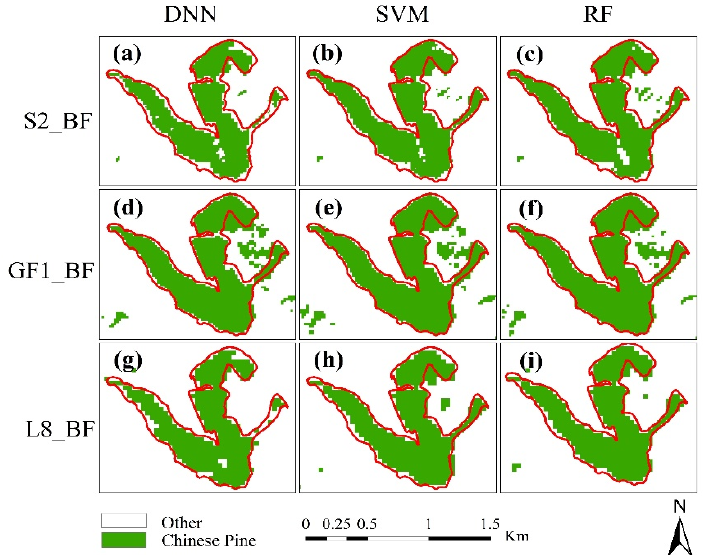
Figure 8. Extraction results of Chinese pine using BF dataset. ( a – c ) The extrction results using Sentinel-2; ( d – f ) The extrc- tion results using Gaofen-1; ( g – i ) The extrction results using Landsat-8 OLI.